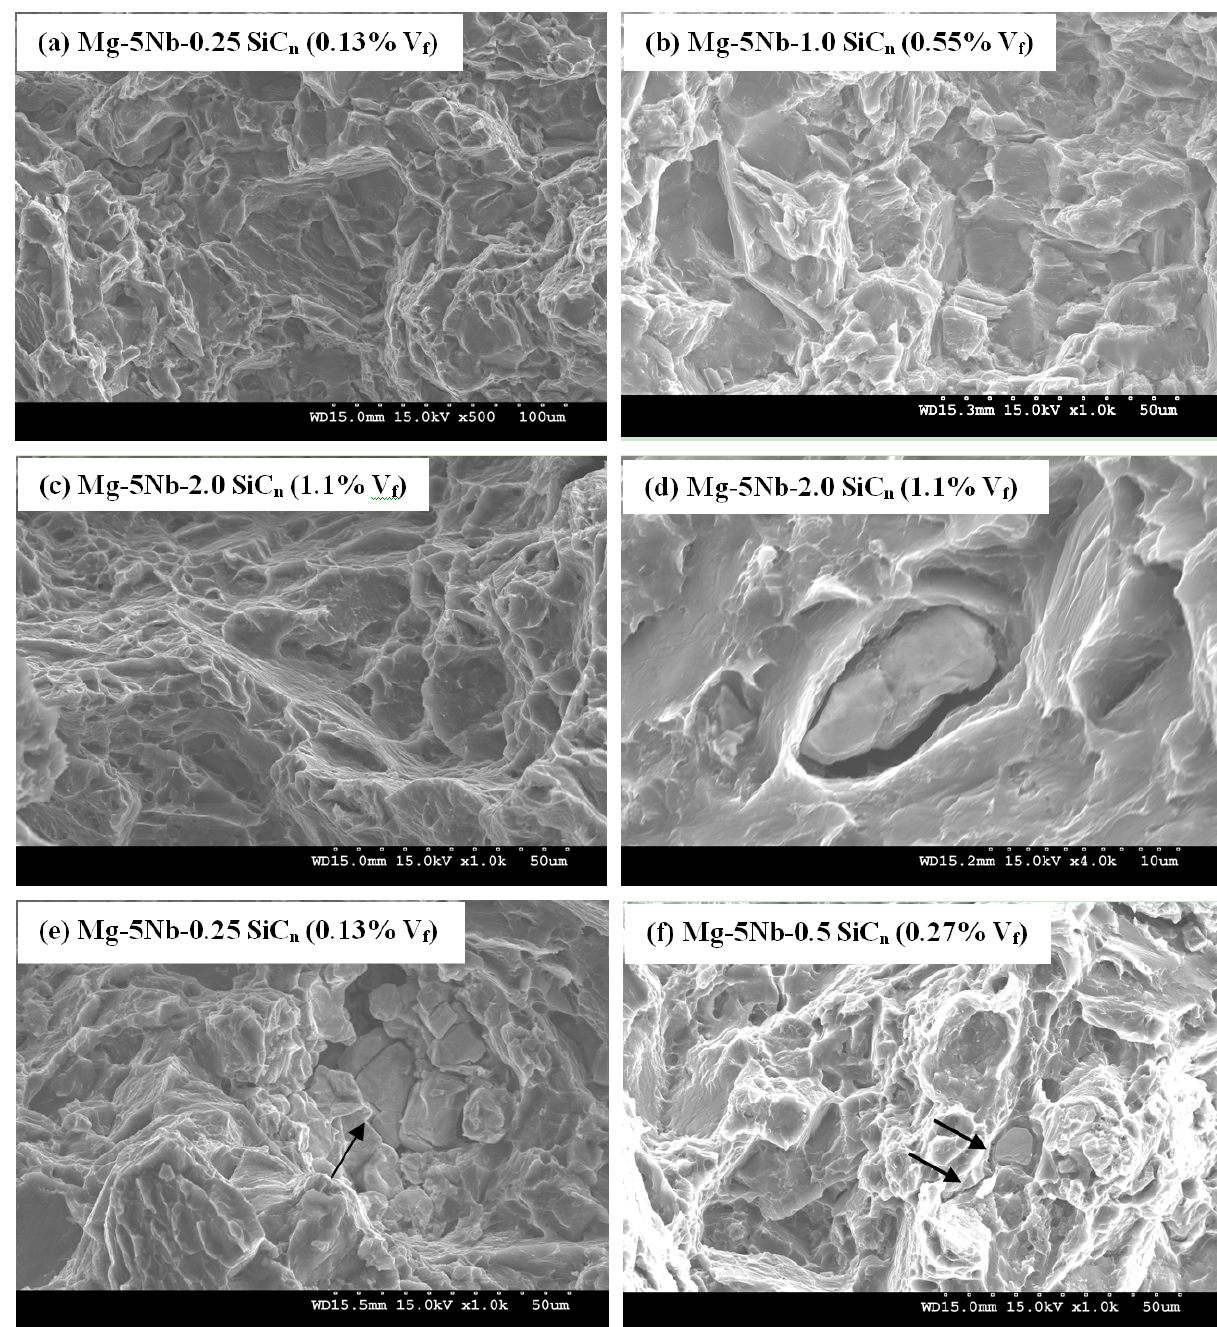
Figure 6. Representative tensile fracture surfaces showing ( a , b ) Brittle fracture features in Mg-5Nb-SiC composites with V : 0.13% and 0.55%; ( c ) regions showing ductile dimples n f in Mg-5Nb-2.0SiC (1.1% V ) composite; ( d ) particle debonding in of Mg-5Nb-2.0SiC n f (1.1% V ) composite; ( e ) crack extension into matrix around debonded Nb/SiC f ( f ) void coalescence around Nb-particle. Representative compressive fracture surfaces showing ( g , h ) dominant shear